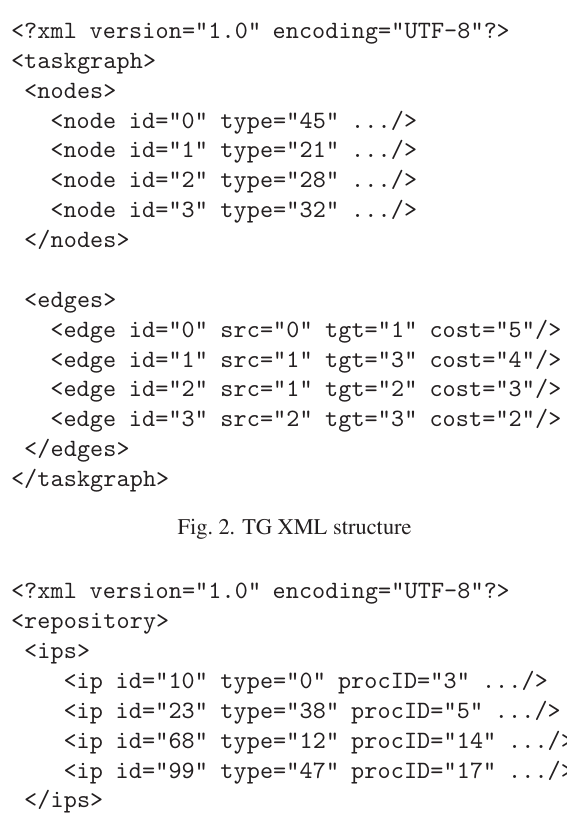
Fig. 1. Example of task graph